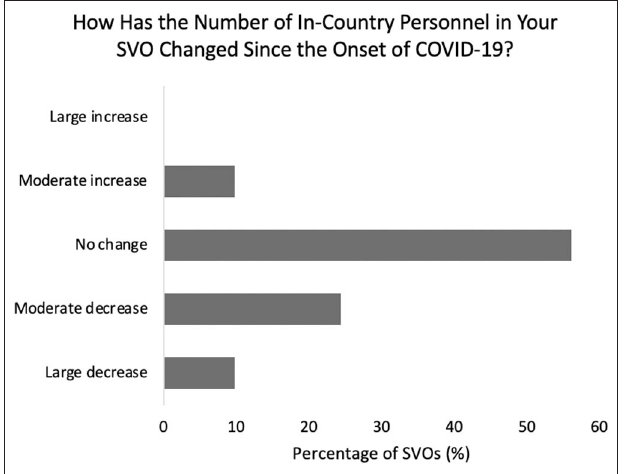
FIGURE 4 | Changes in surgical volunteer organization personnel during the pandemic.